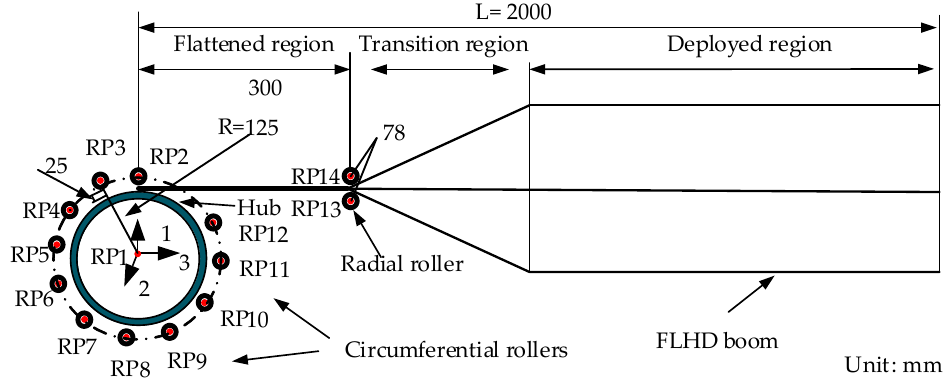
Figure 3. Simplified schematic of the FLHD boom coiling structure.